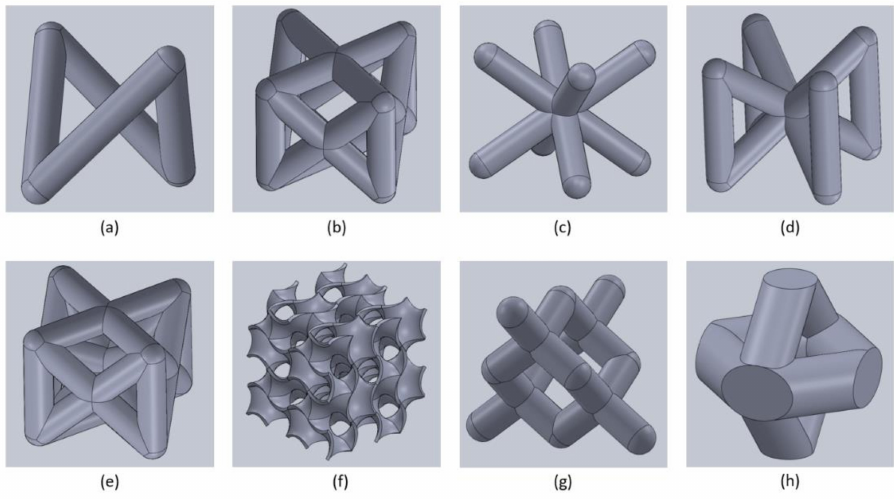
Figure 1. Unit cells in lattice structures: ( a ) FCC; ( b ) F2CC,Z; ( c ) BCC; ( d ) BCC,Z; ( e ) F2BCC,Z; ( f ) gyroid; ( g ) CD; ( h ) Ansys Space-Claim™